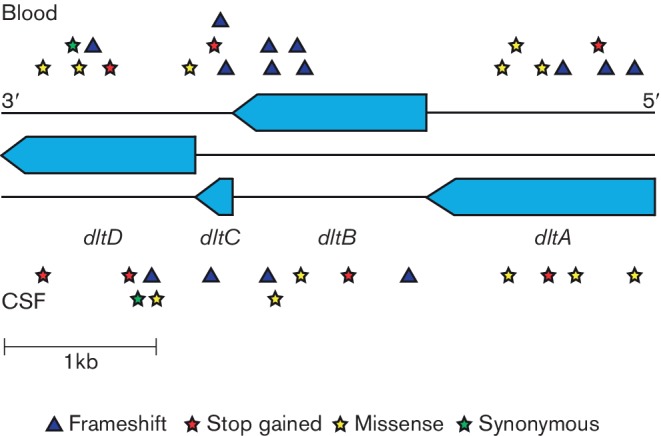
Mutations observed between all paired samples in the dlt operon. The operon consists of four genes in the three reading frames of the reverse strand. Mutations, displayed by type, in the blood strains are shown above the operon, and in the CSF strains below the operon.